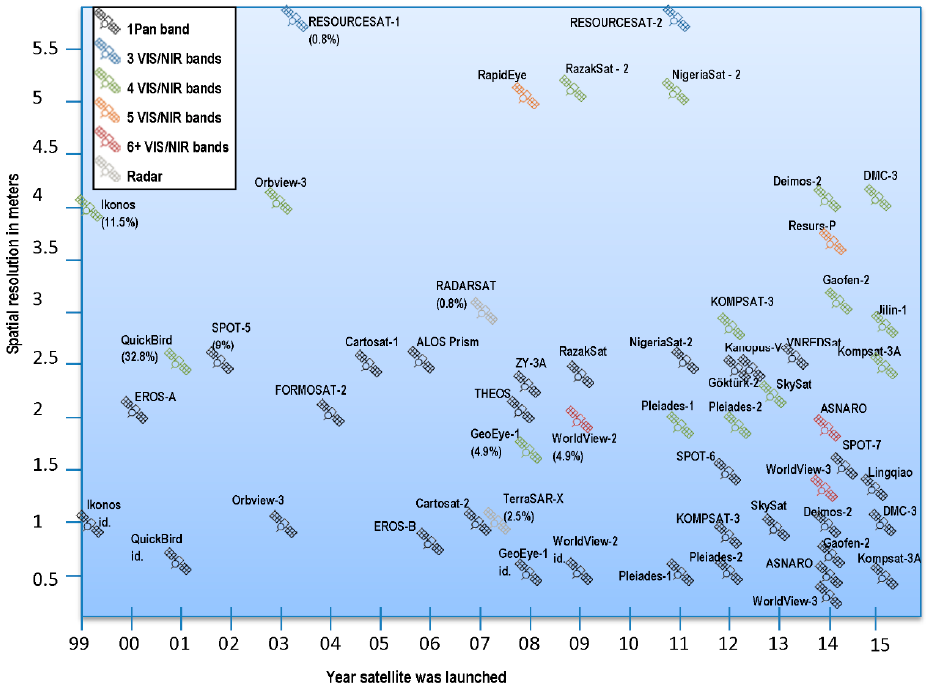
Figure 5. Overview spatial and temporal characteristics of very high and high-resolution satellites; in brackets: percentage of image data sources of reviewed publications (percentages are displayed for the MS bands (when available): this combines the percentage of MS and PAN bands) ( N = 122, some publications use multiple image data, in addition to aerial sensors: 8.2%, GE: 6.6%, and moderate resolution systems: Landsat: 8.2%, Envisat ASAR: 4.9%, Terra ASTER: 2.5%, PALSAR: 1.6%, MODIS: 0.8%).